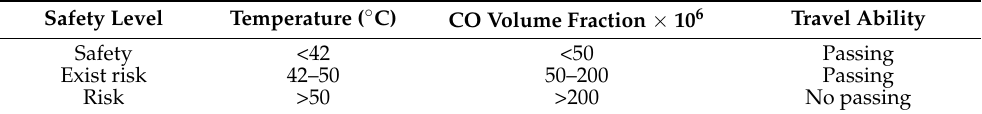
Table 3. Temperature and CO thresholds during the evacuation path.